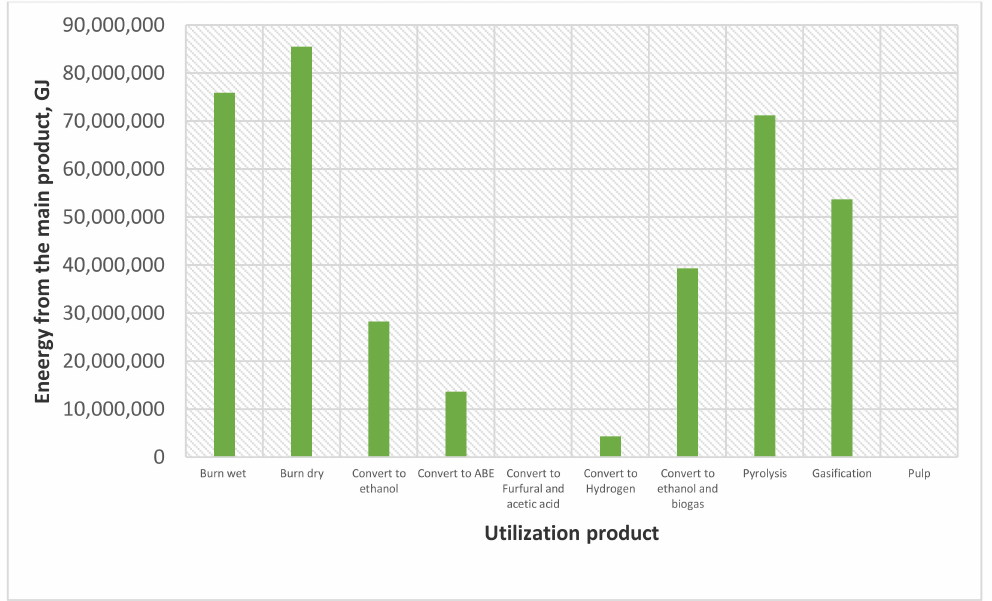
Figure 5. Energy content of the products from different utilisation processes of bagasse, the leftover solid was not considered in the